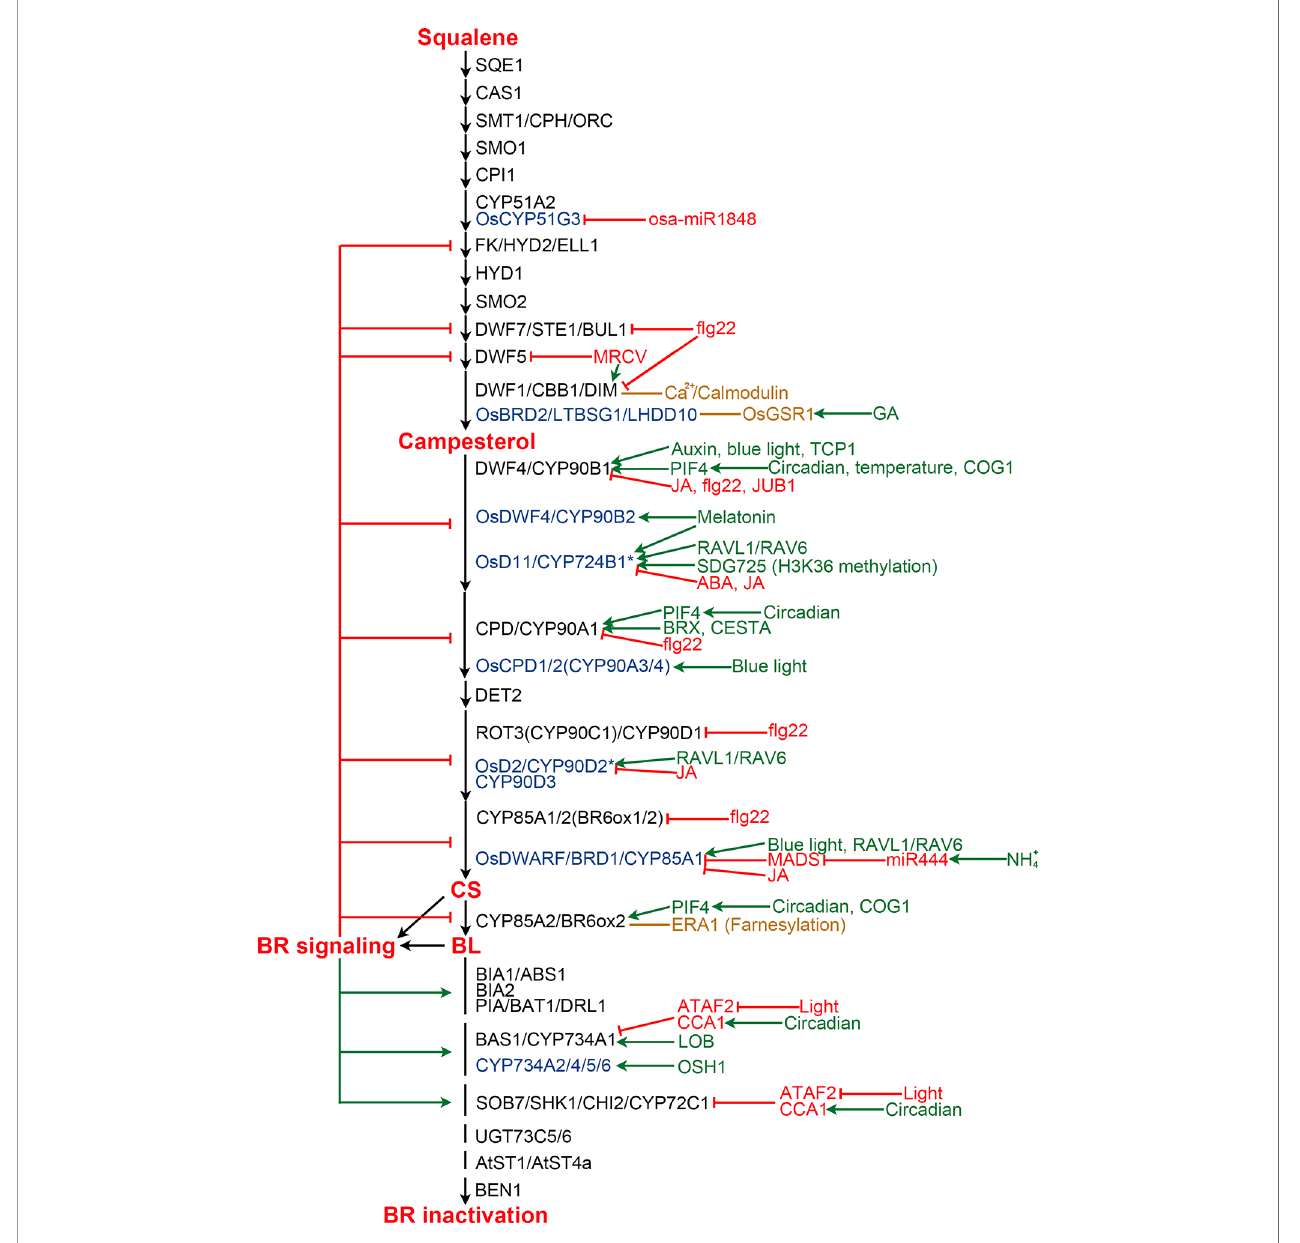
FIGURE 3 | Regulation of BR biosynthesis and catabolism in Arabidopsis and rice. BR biosynthesis pathway is shown from squalene to BL. Enzymes from Arabidopsis and rice are shown in black and blue colors, respectively. Enzymes marked by an asterisk are those with controversial functions. Enzymes from other plants are list in Table 2 and Table 3 . Green and red arrows indicate positive and negative regulation, respectively. Orange lines represent protein-protein